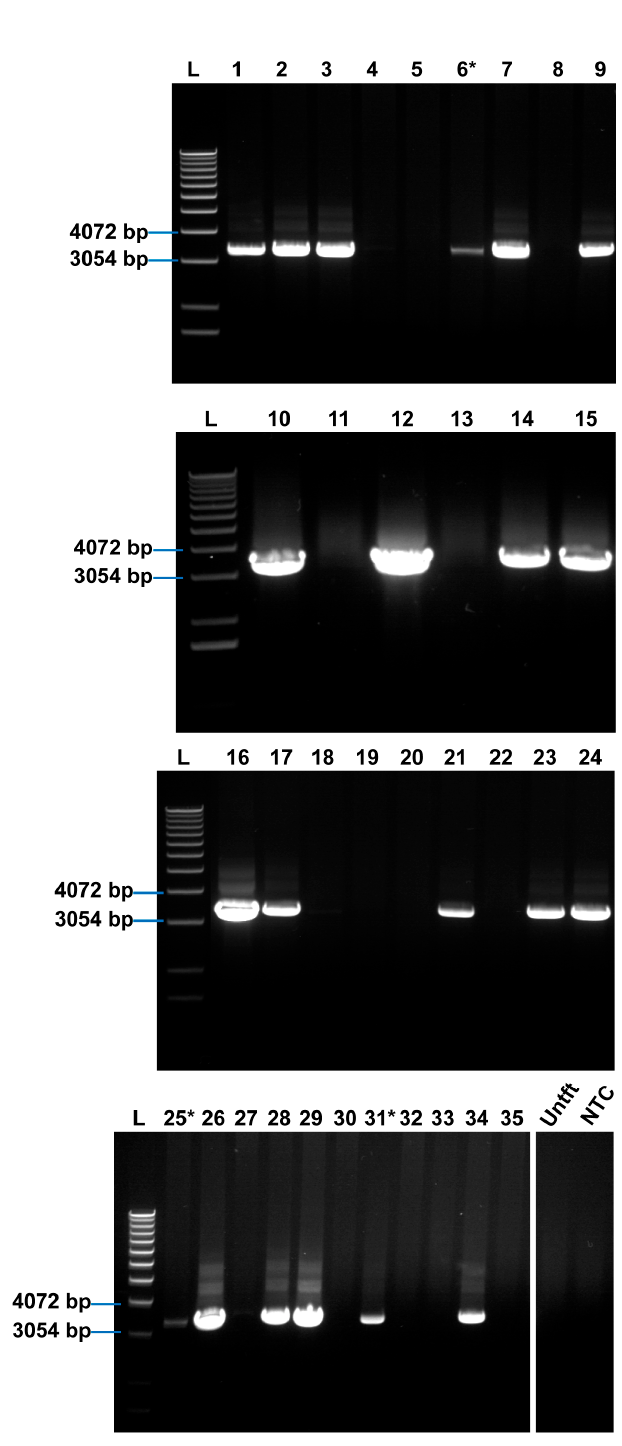
Figure A1. 0.8% agarose gel electrophoresis of a total of 35 viable clones screened by 3 ′ -HA PCR. 500 ng gDNA templates (numbered as 1 to 35) were amplified at the annealing temperature of 65 °C for 30 cycles, with gDNA template from untransfected (Untft) E14-Bra-GFP mESCs cultured on gelatine as a negative control. A non-template control (NTC) was also included where template gDNA was substituted by nuclease-free water. Eighteen out of 35 viable clones show bright positive bands and three show weaker bands (indicated by asterisks) of the correct size of 3380 bp. L, 1 kb ladder.